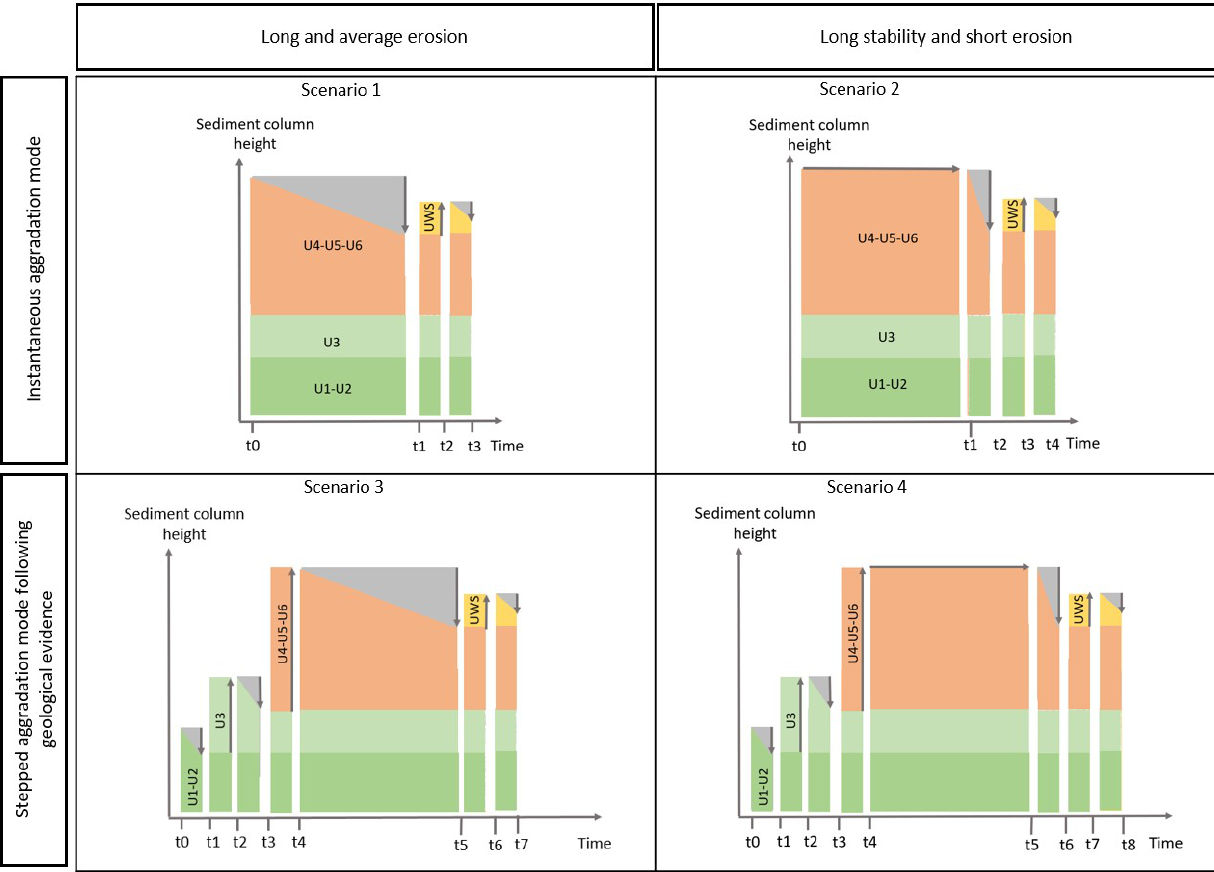
Figure 5. The four scenarios that are developed to represent the sedimentary sequence of the Zutendaal gravels in As. Grey arrows represent aggradation (upward arrow), erosion (downward arrow) or stability (horizontal arrow). The material that is removed by erosion is coloured in